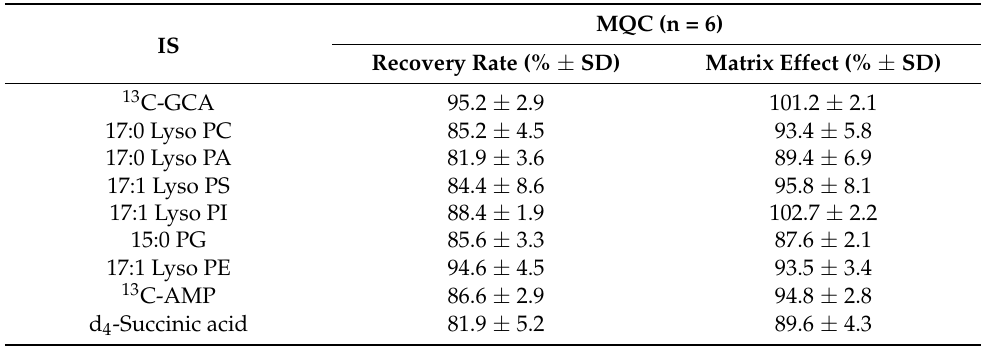
Table 2. Recovery and matrix effect data of the target